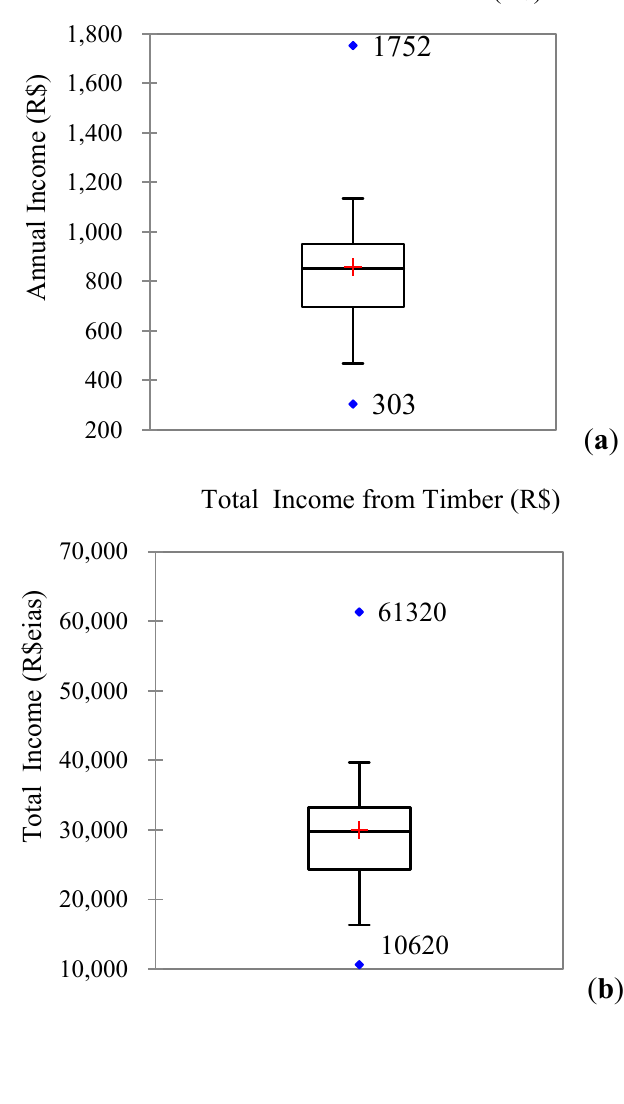
Figure 4. Mean, minimum and maximum of annual ( a ) and total incomes ( b ) from timber